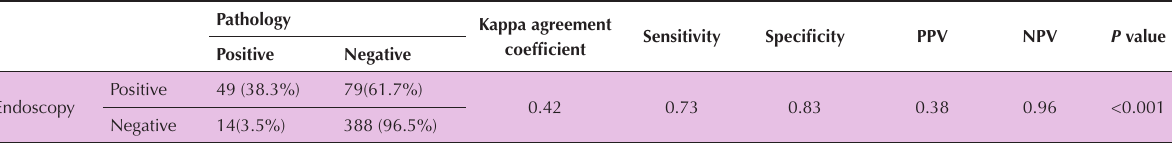
Table 1. p Kappa agreement coefficient and sensitivity and specificity